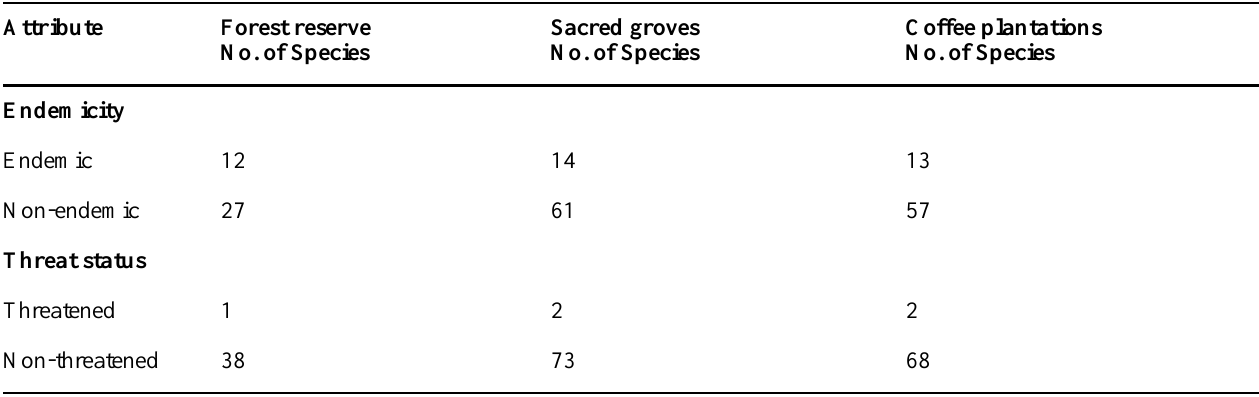
Table 3. The distribution of endemic and threatened birds in Kodagu, Western Ghats of India Attribute Forest reserve No. of Species